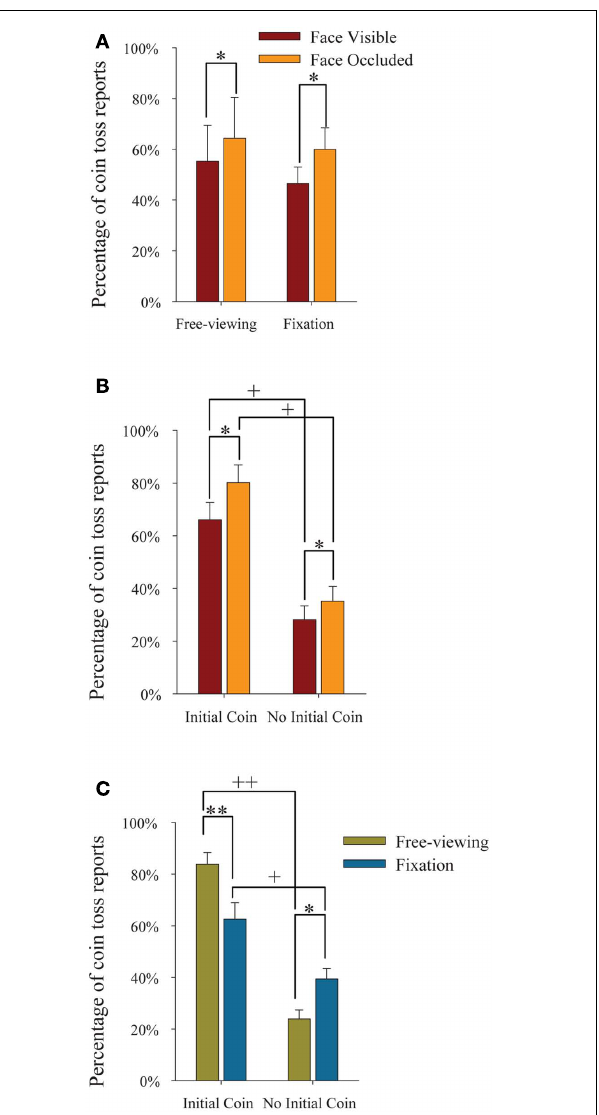
FIGURE 6 |Average percentage of coin toss reports according to viewing condition, presence of an initial coin, and presence/absence of social misdirection. (A) Percentages of button presses for free-viewing and fixation conditions, with the magician’s face visible versus occluded. Error bars represent SEM across all five types of performance ( N = 5 conditions). (B) Percentages of button presses for types of performance in which an initial coin was present versus absent, with the magician’s face visible versus occluded. Error bars under Initial Coin condition represent SEM across six conditions, i.e., Face visible and Face occluded, for Magic Trick, RealToss andTwo-Coin FakeToss. Error bars under No Initial Coin condition represent SEM across four conditions, i.e., Face visible and Face occluded, for Final Coin FakeToss and No Coin FakeToss. (C) Percentages of button presses according to the presence/absence of an initial coin, with free-viewing versus fixation conditions. Error bars under Initial Coin condition represent SEM across six conditions, i.e., Free-viewing and Fixation, for MagicTrick, RealToss andTwo-Coin FakeToss. Error bars under No Initial Coin condition represent SEM across four conditions, i.e., Free-viewing and Fixation, for Final Coin FakeToss and No Coin FakeToss. *Paired t -test, p < 0.05; **Paired t -test, p < 0.001; + Two-sample t -test, p < 0.05; ++ Two-sample t -test, p <